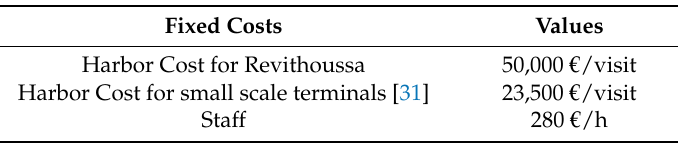
Table 10. Fixed costs in a LNG terminal